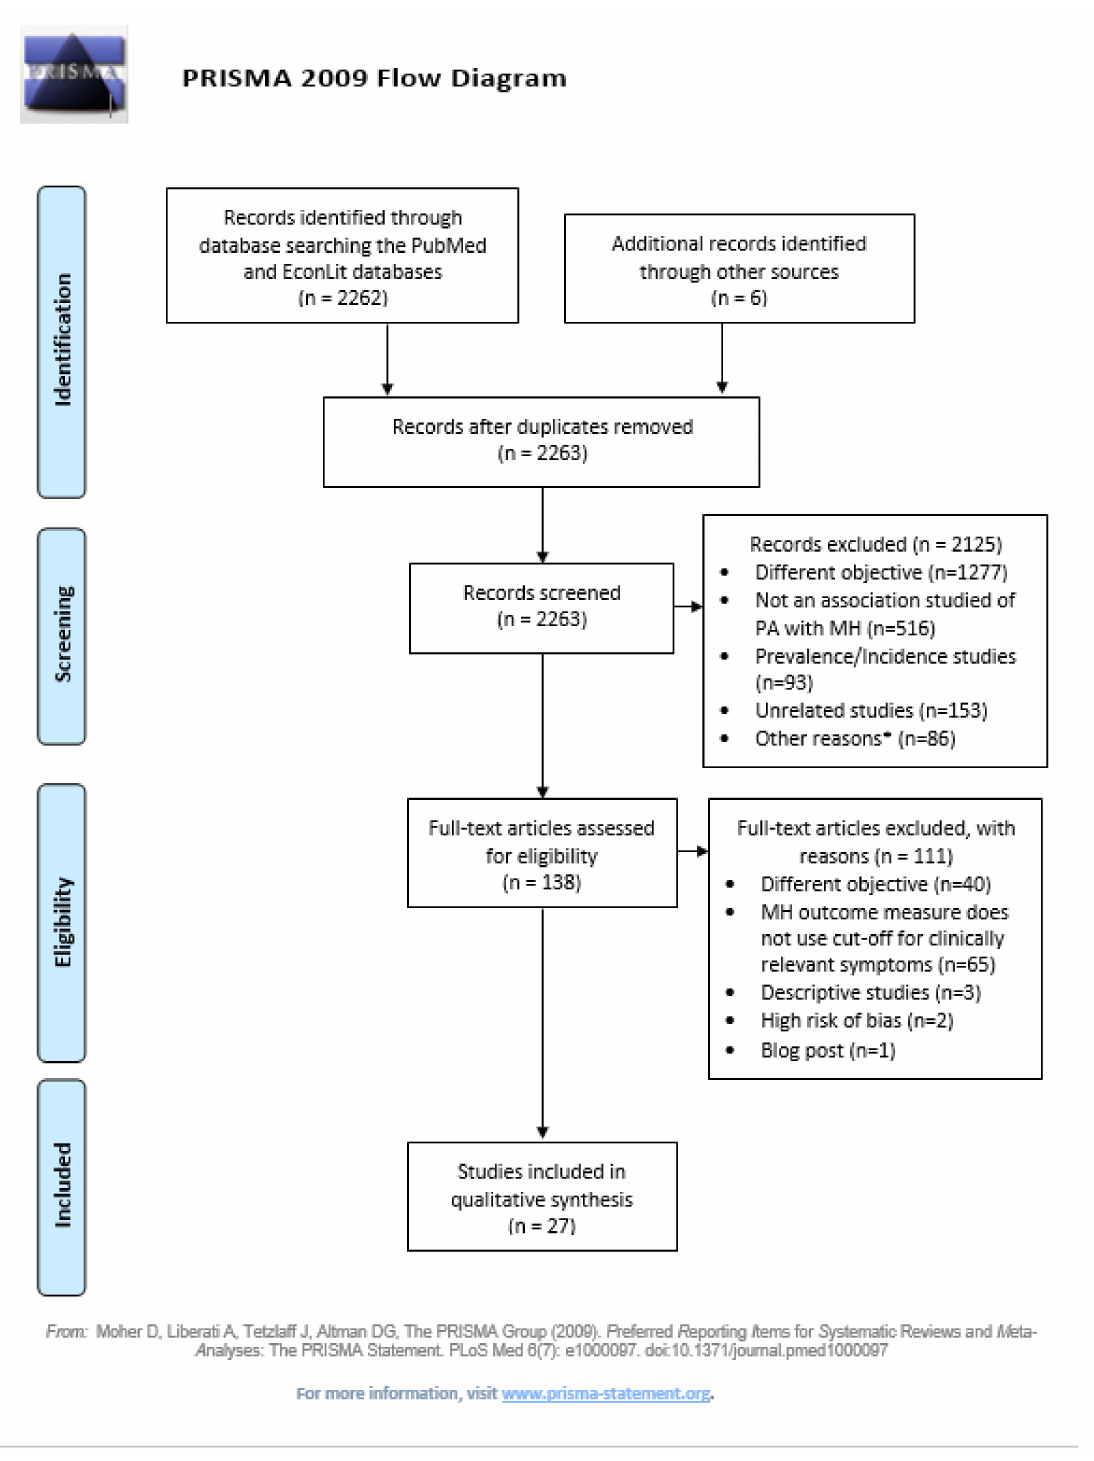
Figure 2. PRISMA flow diagram. * Other reasons for exclusion at the eligibility stage included: systematic reviews or meta-analyses (n = 48), studies of small sample size (n = 9), studies that were work in progress (n = 8), guidelines (n = 6), indirect influence of PA with MH measured only (n = 4), pilot studies (n = 3), MH outcome does not use cut-off for clinically relevant symptoms (n = 2), descriptive studies (n = 1), associations based on beliefs (n = 1), convenience sample (n = 1), not in English or Spanish (n = 1), qualitative studies (n = 1), and specific population with risk of selection bias (n =